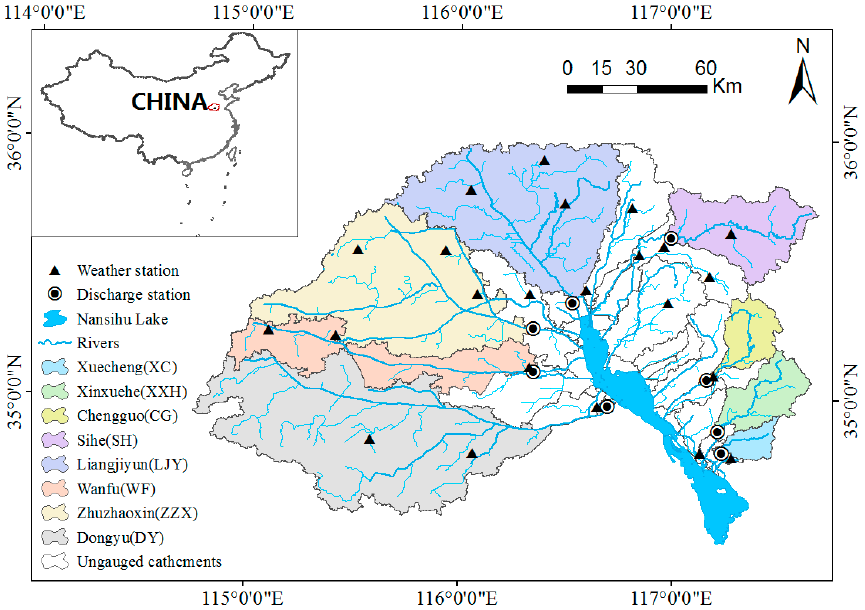
Figure 1. Map showing the study catchments.